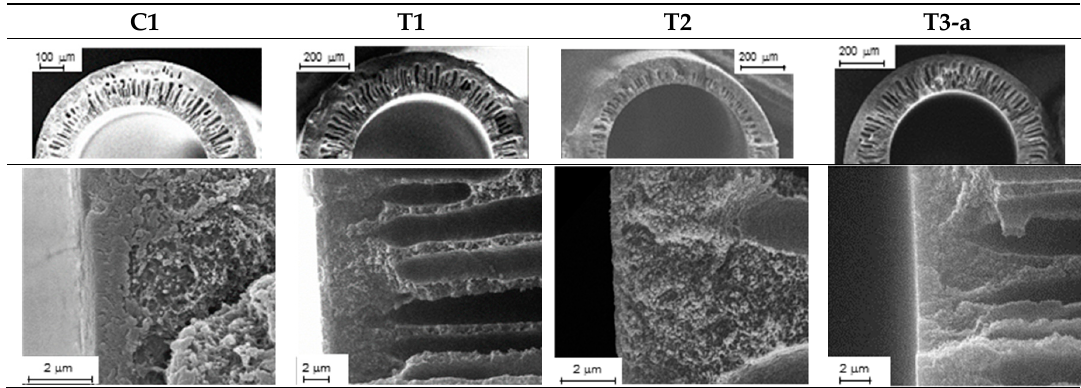
Figure 3. SEM images of the cross-section (up) and inner layer (down) for the investigated HFs.